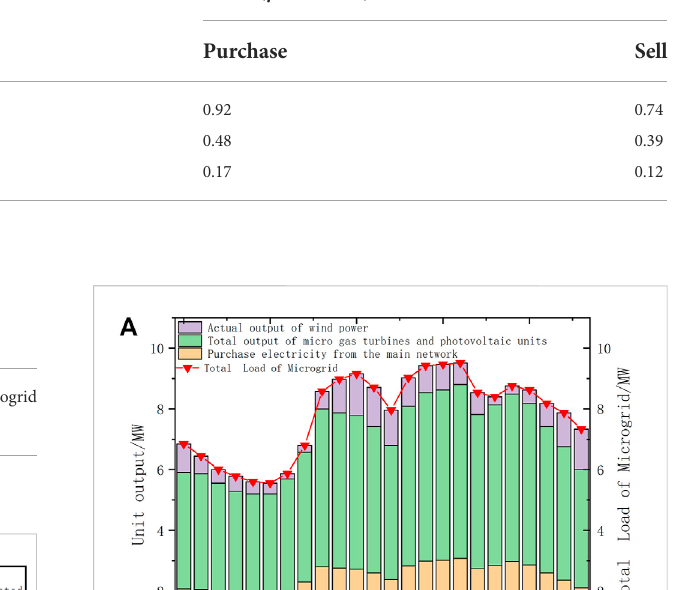
TABLE 2 Time-of-use electricity prices.